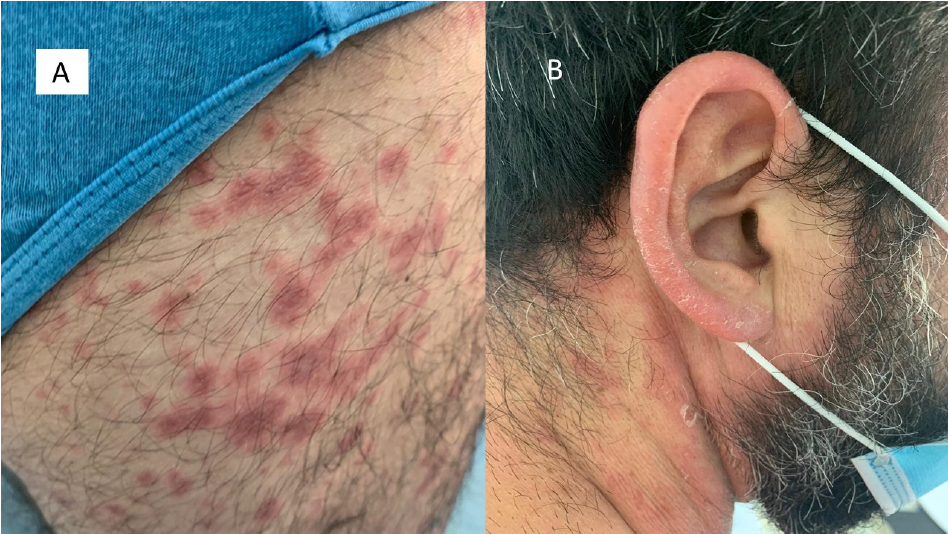
Figure 1. ( A ) Examples of an erythema multiforme-like lesion in the first group of patients. Note the detail of the violaceous erythematous well-defined border lesions with a typical targetoid aspects; ( B ) “ Targetoid ” type lesions with initial desquamation at the level of the periauricular area.